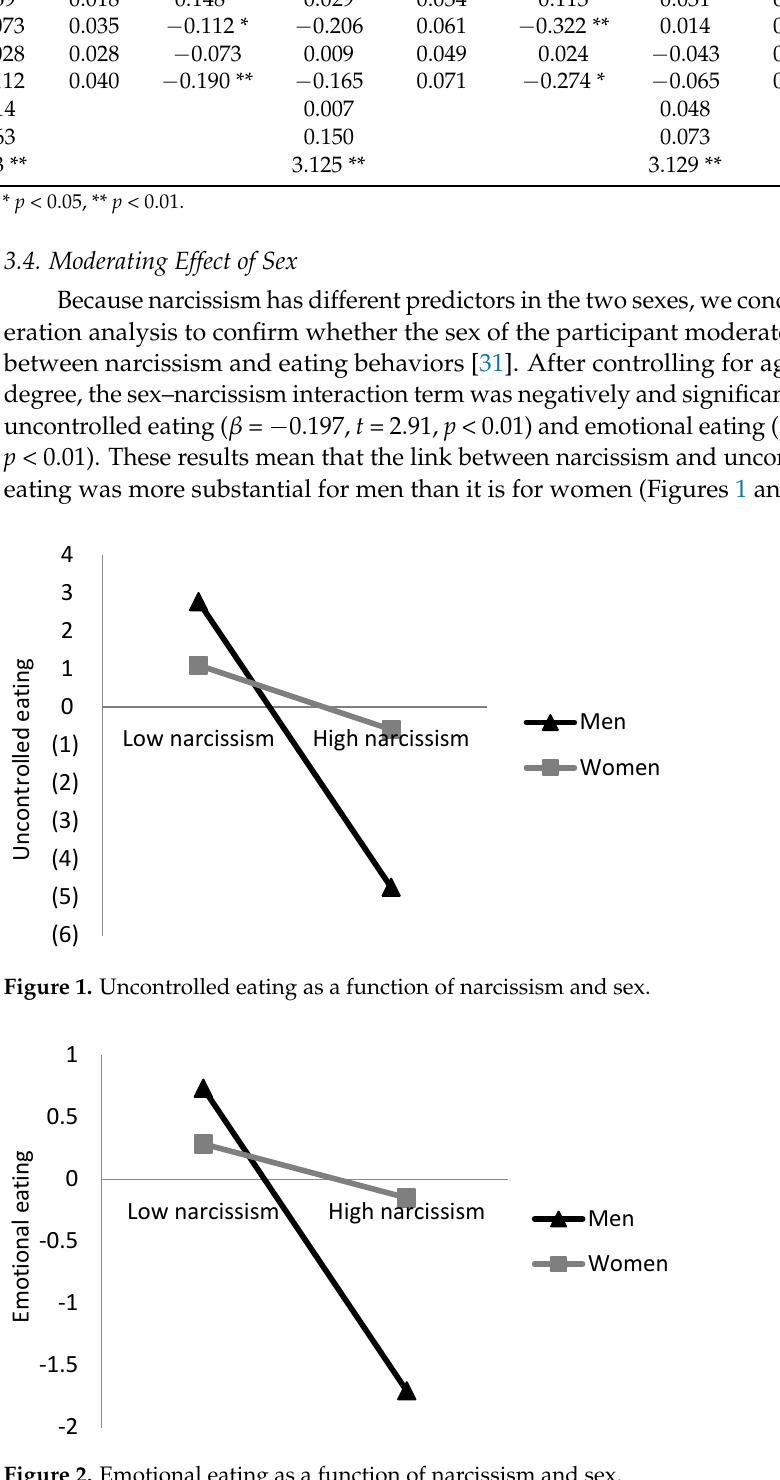
Figure 2. Emotional eating as a function of narcissism and sex.